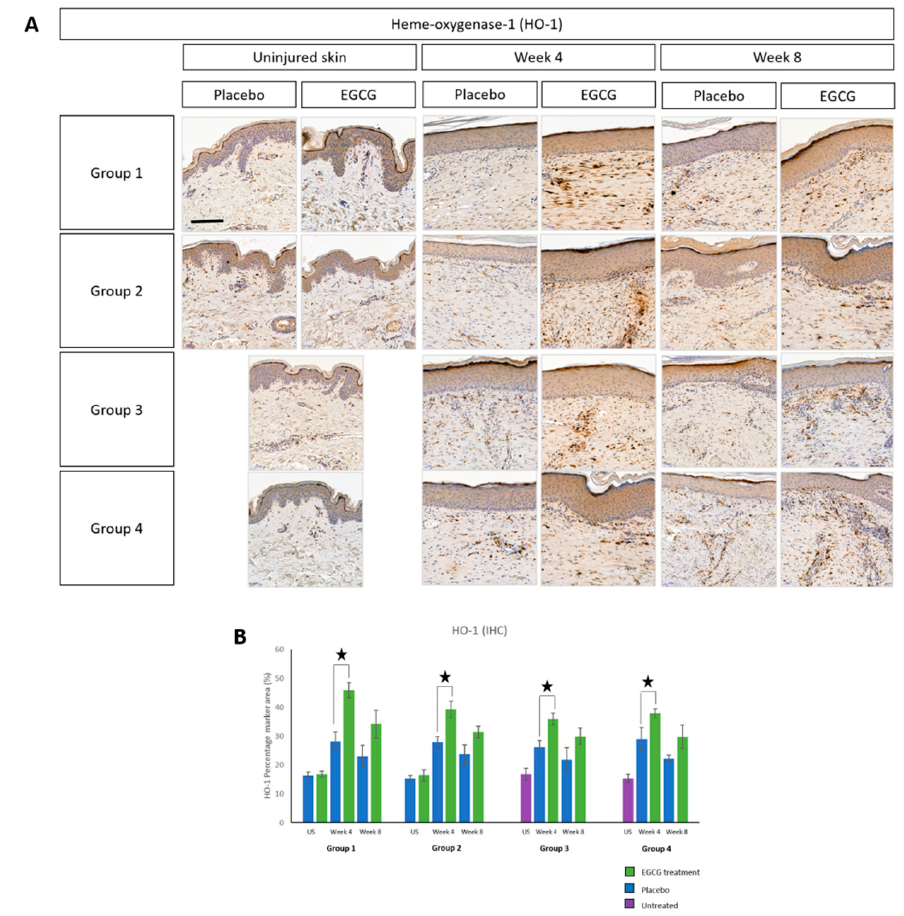
Figure 19. Antioxidant Heme-oxygenase 1 (HO-1) effects of topical epigallocatechin-3-gallate (EGCG) versus placebo. ( A ) HO-1 immunohistochemical stain images. ( B ) HO-1 percentage marker area measurements. Scale bars = 100 μ m. Error bars: mean ± SD. Significance: ★ p ≤ 0.01.